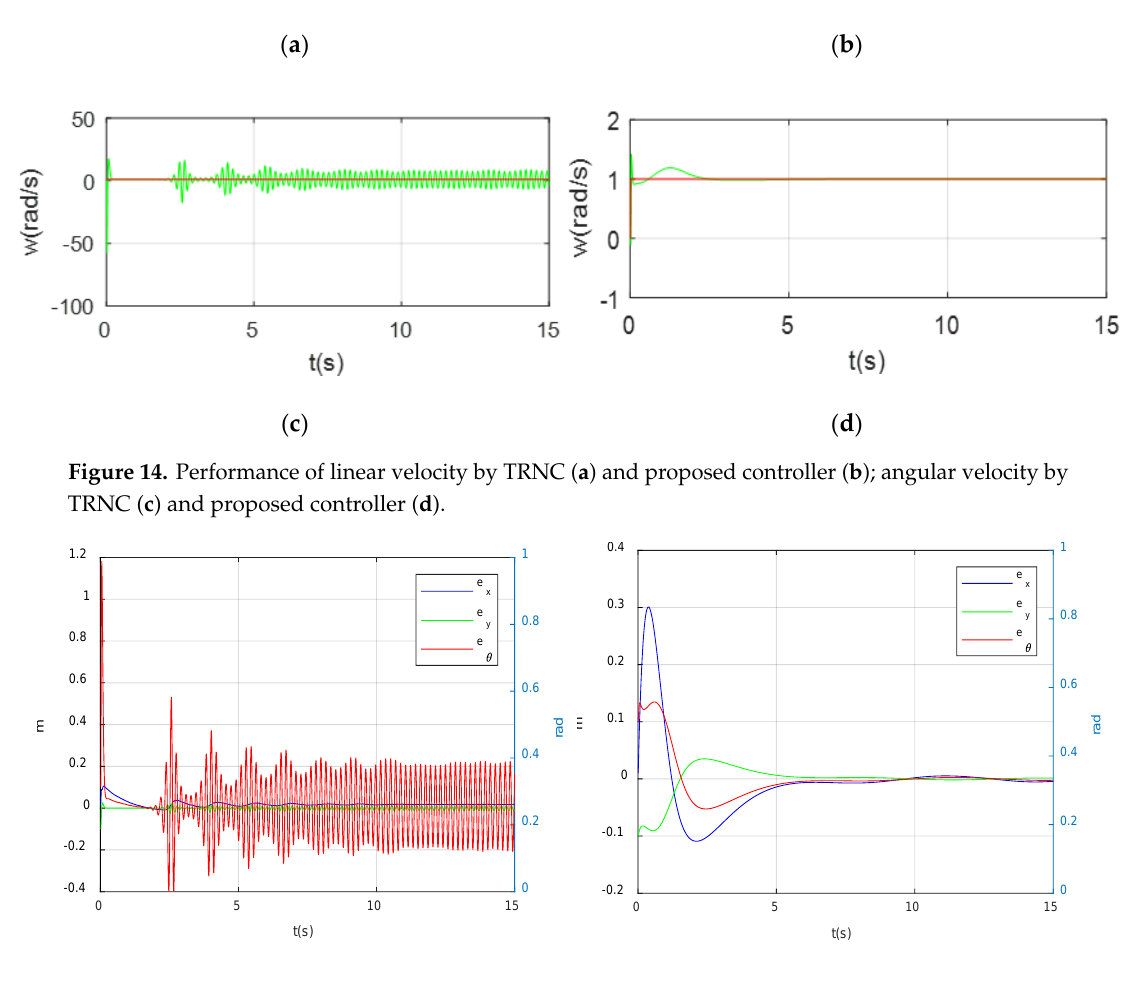
Figure 15. Performance of tracking errors by TRNC ( a ) and proposed controller ( b